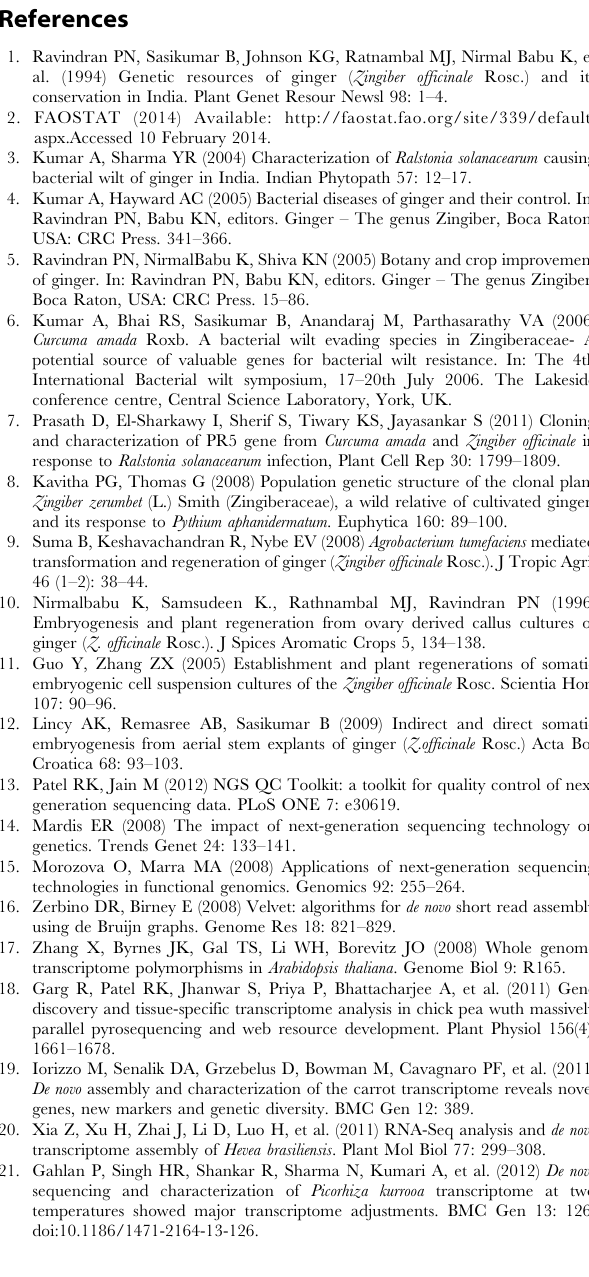
Figure S2 Snapshots of the public access resource gTDB showing its various utilities. Table S1 List of genes differentially expressed in C. amada and Z. officinale along with their expression values. Table S2 List of functional categories of differentially expressed genes in in C. amada and Z. officinale along with their expression values. Table S3 List of upregulated genes unique to C. amada during infection with R. solanacearum .